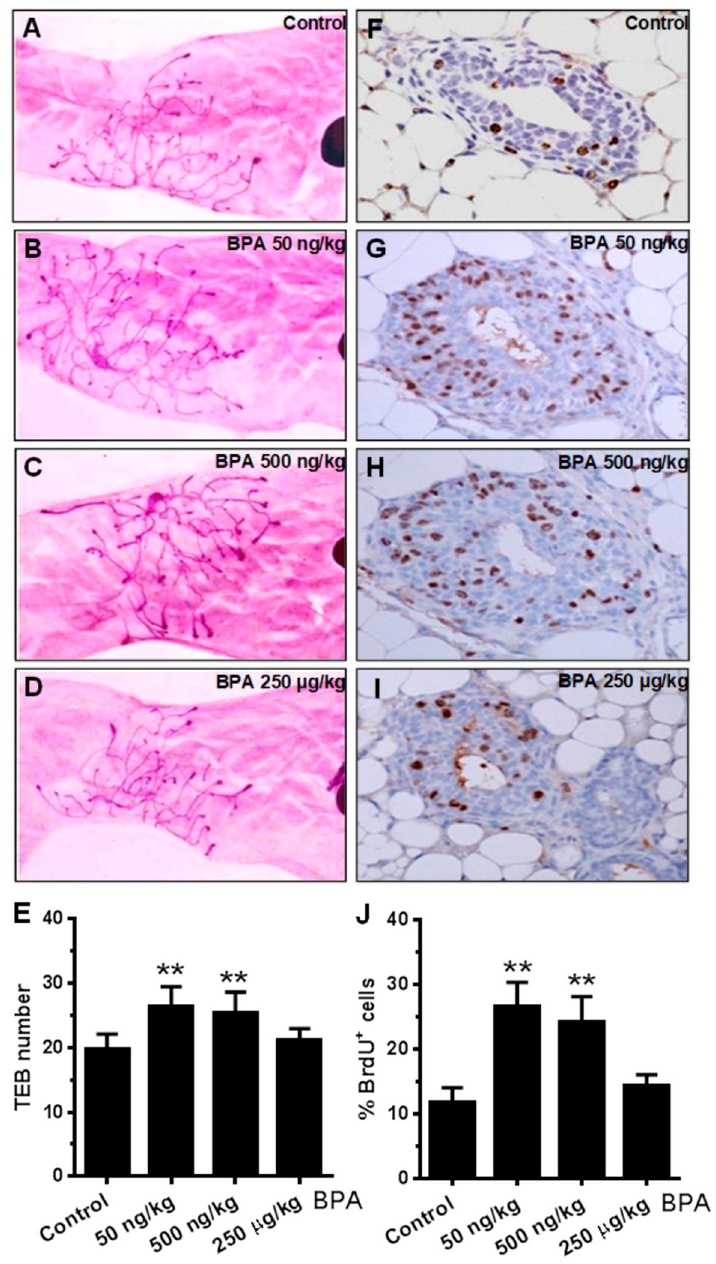
Figure 2. In utero BPA exposure a ff ects terminal end bud (TEB) number and BrdU expression